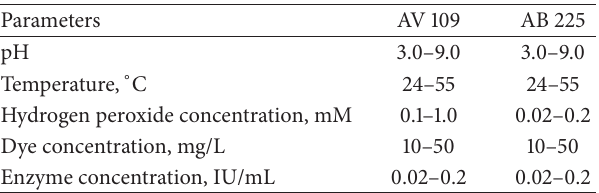
Table 2: The investigated range of the reaction parameters selected for the optimization of dyes